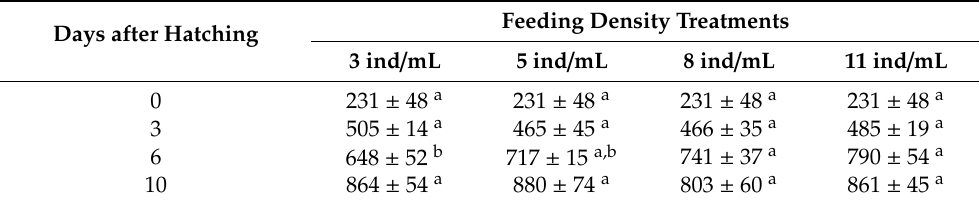
Table 4. Mouth opening gape ( µ m) of P. hypophthalmus larvae at four developmental time points following subjection to di ff erent feeding density treatments. Feeding Density Treatments Days after Hatching 3 ind / mL 5 ind / mL